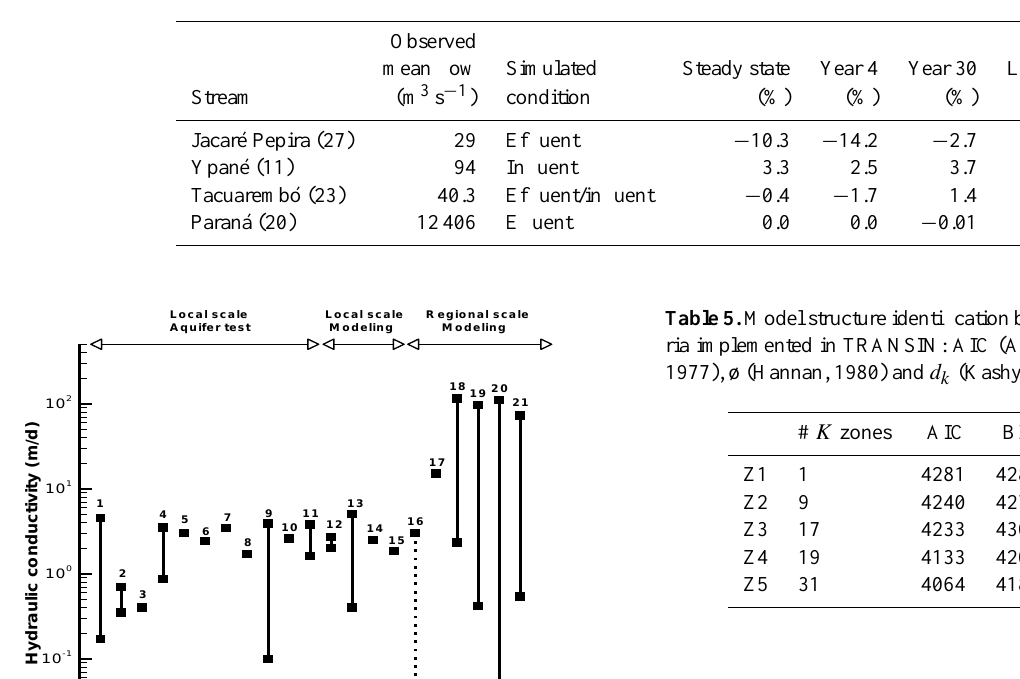
Table 4. Comparison between stream–aquifer fluxes with streamflow for selected streams and simulation years (percentages express stream leakage relative to mean streamflow).